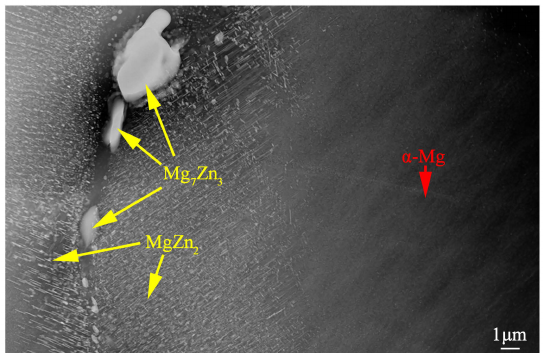
Figure 5. HADDF-STEM (high-angle annular dark-field scanning transmission electron microscope) image of the as-homogenized ZM51 alloy.